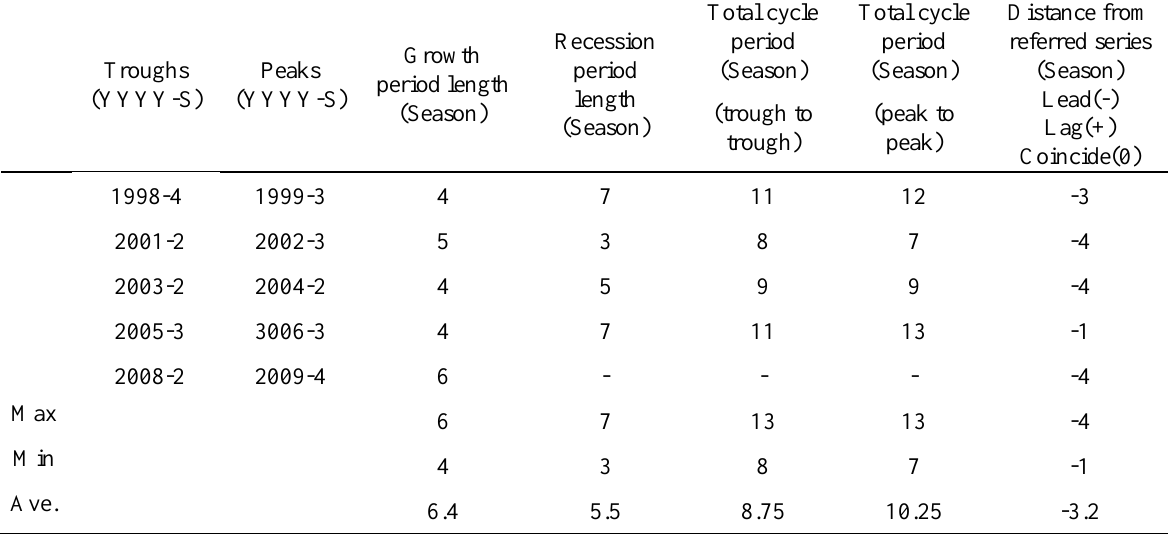
Table 8. Turning points of equal weighting CLI and its comparison with reference series